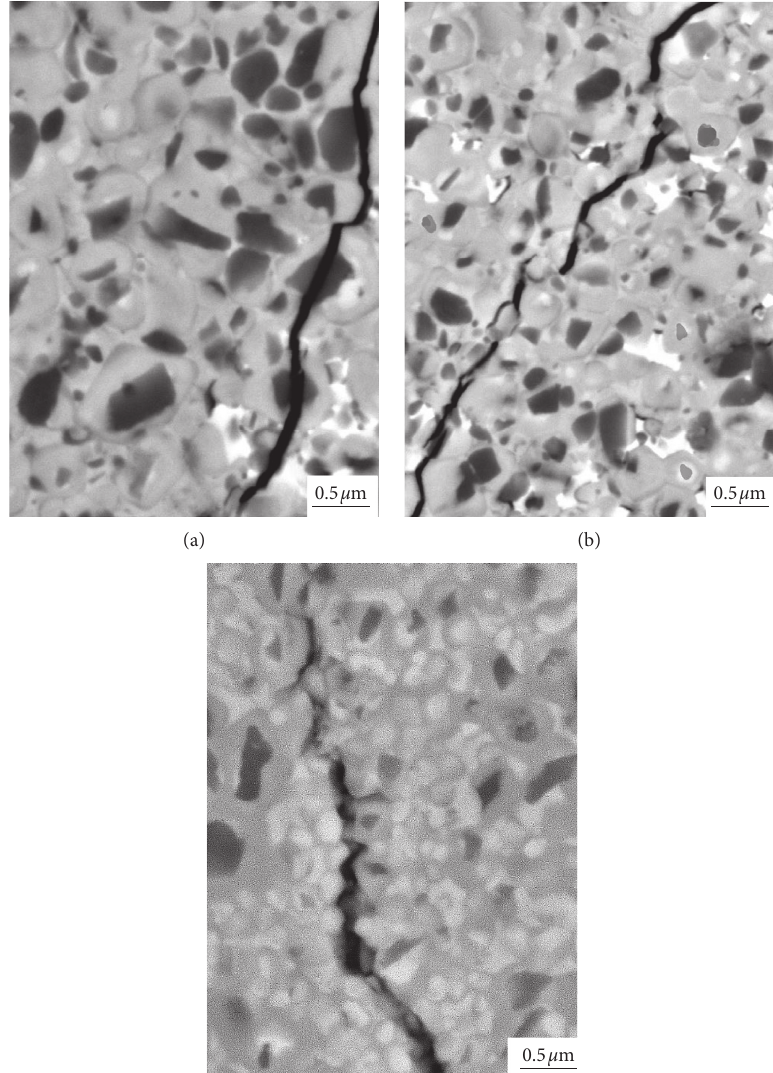
Figure 9: BSE morphology of crack propagation